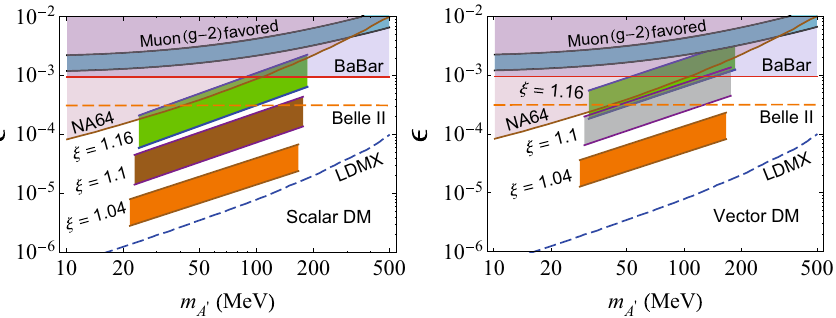
Fig. 2 The value of (cid:4) as a function of m A (cid:4) for scalar and vector mil- and the region preferred by the muon g − 2 [34] is denoted in the figure. = 1 is adopted. For licharged DM with ξ = 1 . 16, 1.1 and 1.04. Here e The upper and lower dashed curves are the expected sensitivity of Belle D the band of a given ξ , the upper (lower) limit is for f DM = 0 . 003 (0.02), II 20 fb − 1 [35] and the ultimate reach of Light Dark Matter eXperiment respectively, with the range of f DM indicated by the 21-cm anomaly. (LDMX) [36], The upper limit of (cid:4) has constraints from NA64 [31] and BaBar [32],